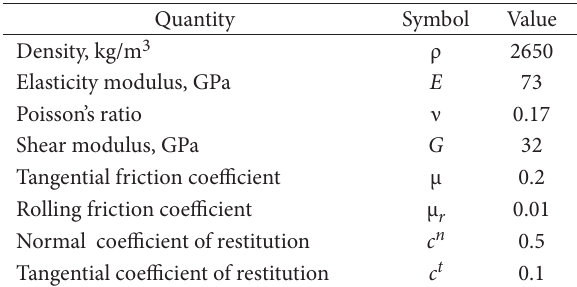
Table 1. Major data on the sand